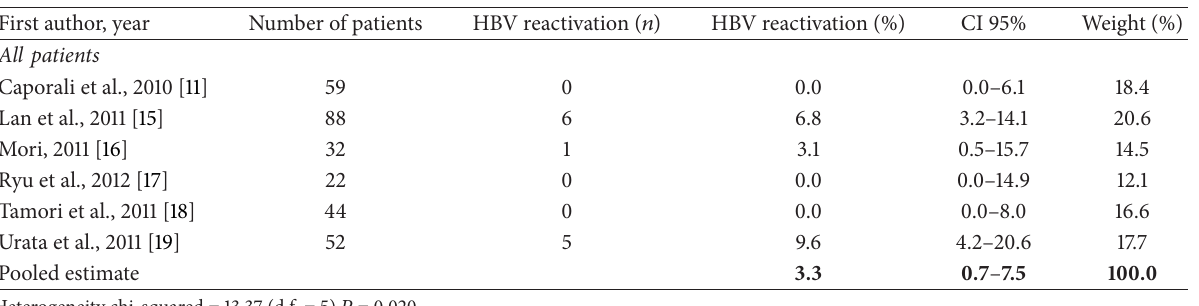
Table 3: Meta-analysis on HBV reactivation among patients with rheumatoid arthritis treated with biologic agents.